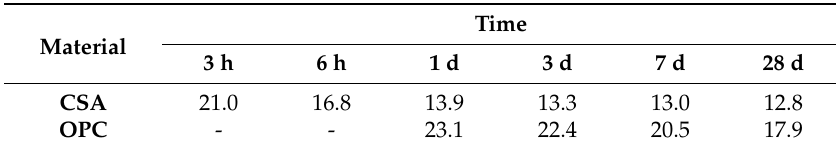
Table 4. Free water content in bulk (wt%).